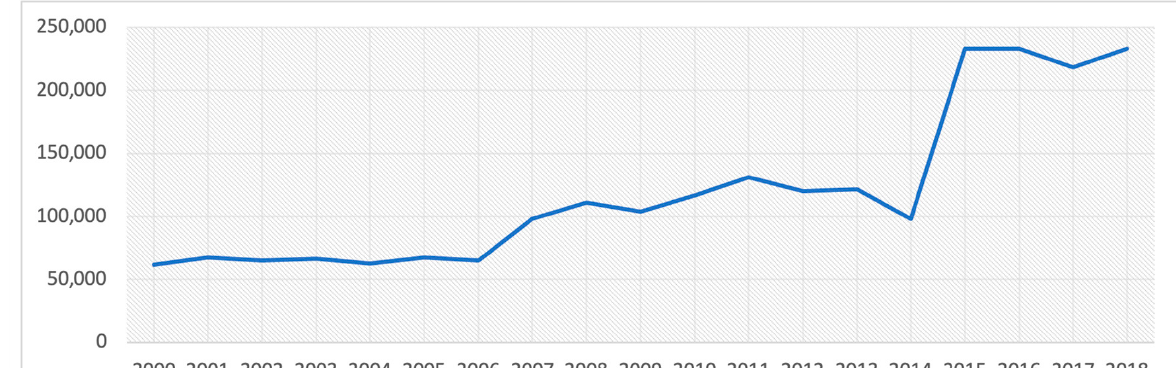
Figure 1. Air pollution (PM10) trend (Ton) [1] .